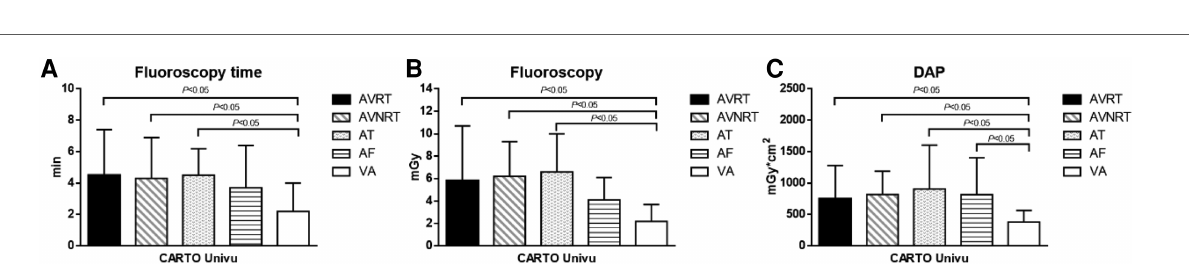
FIGURE 2 Comparison of fl uoroscopy during procedures between the C3 and C3U groups. ( A ) Shows the fl uoroscopy time; ( B ) shows the fl uoroscopy dose; and ( C ) shows the dose area product (DAP).